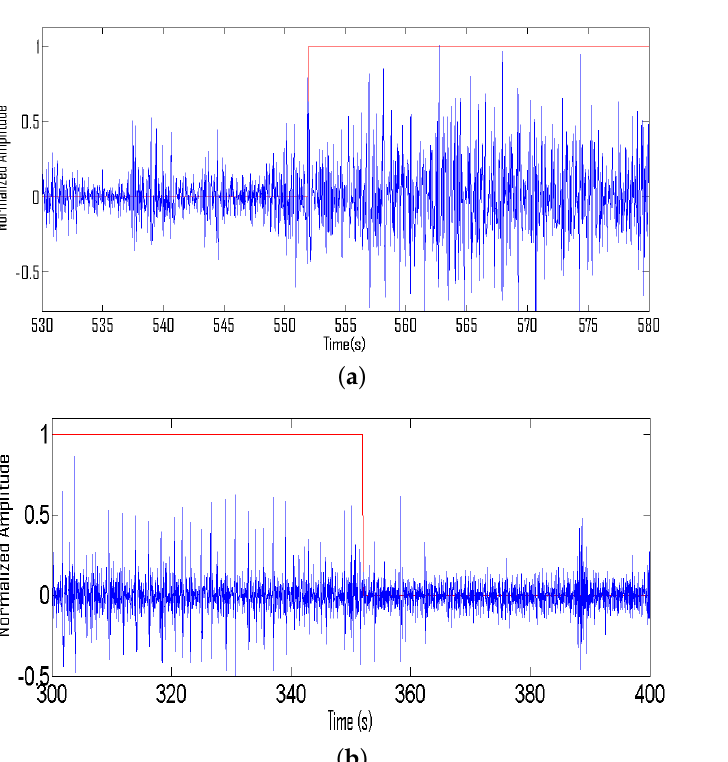
Figure 7. ( a ) Averaged and downsampled EEG signal just before and after the start of seizure activity, ( b ) Averaged and downsampled EEG signal just before and after the start of seizure activity.